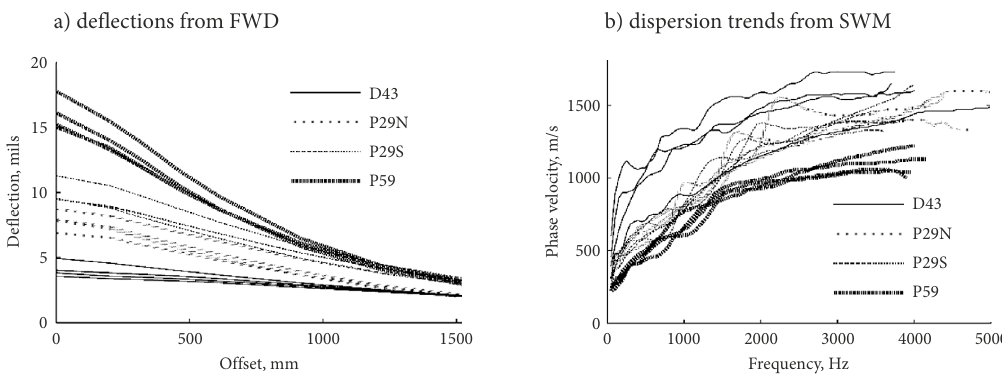
Figure 2. Experimental data for the first four sites